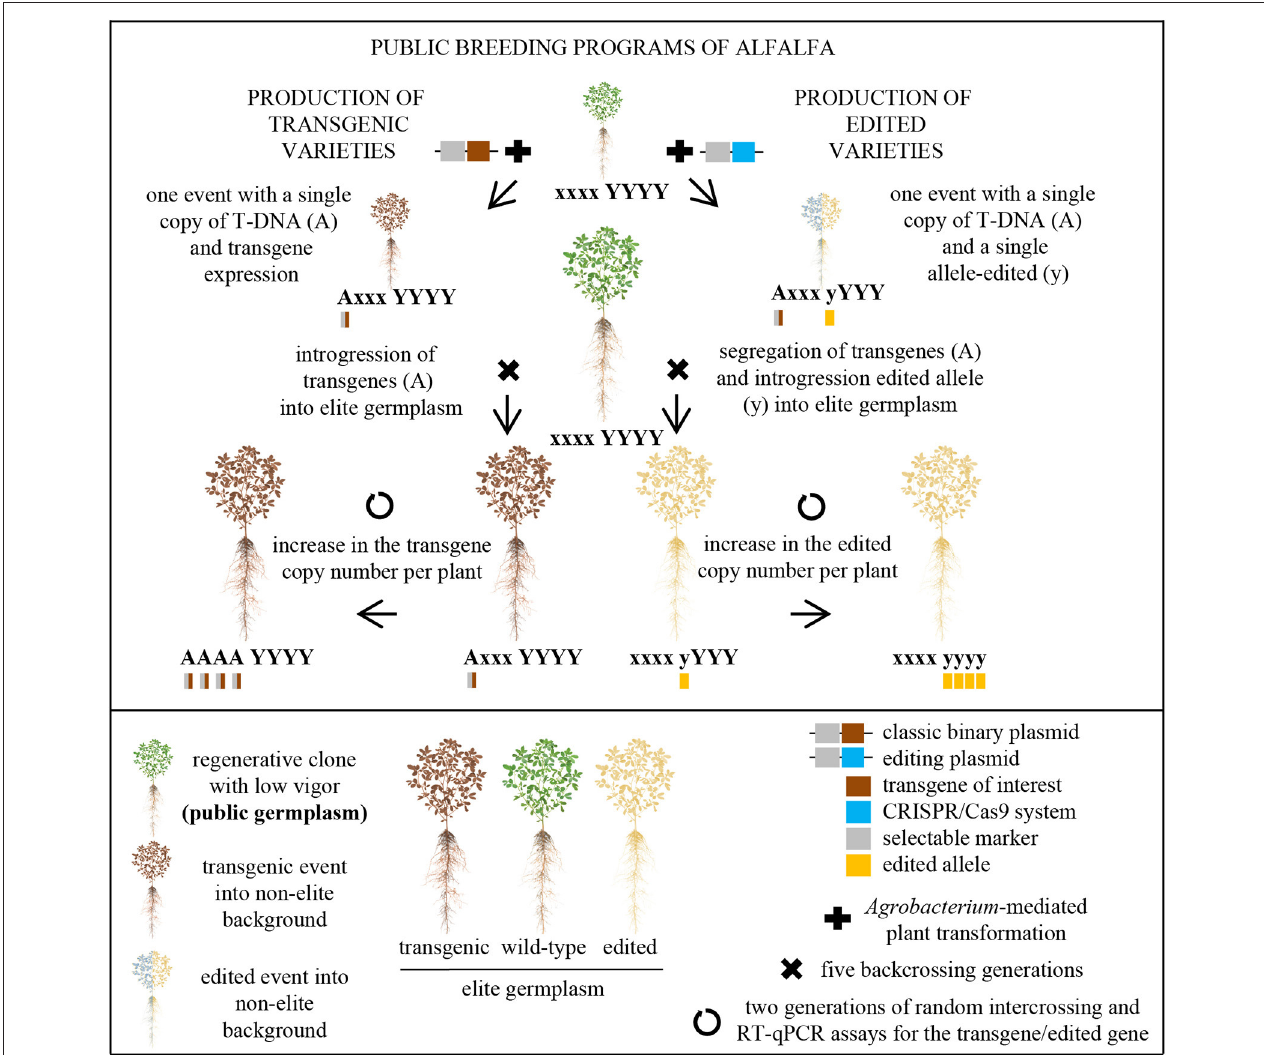
FIGURE 3 | Schematic representation of the similarities between the production of public commercial alfalfa varieties containing only one transgenic (left) or edited (right) trait. These approaches contain the same three critical steps: the transformation of a public alfalfa germplasm (e.g., clone C23) with a binary plasmid via Agrobacterium tumefaciens , the introgression of the transgene or the edited allele into elite germplasm, and the increase in the transgenic or the edited copy number per plant.